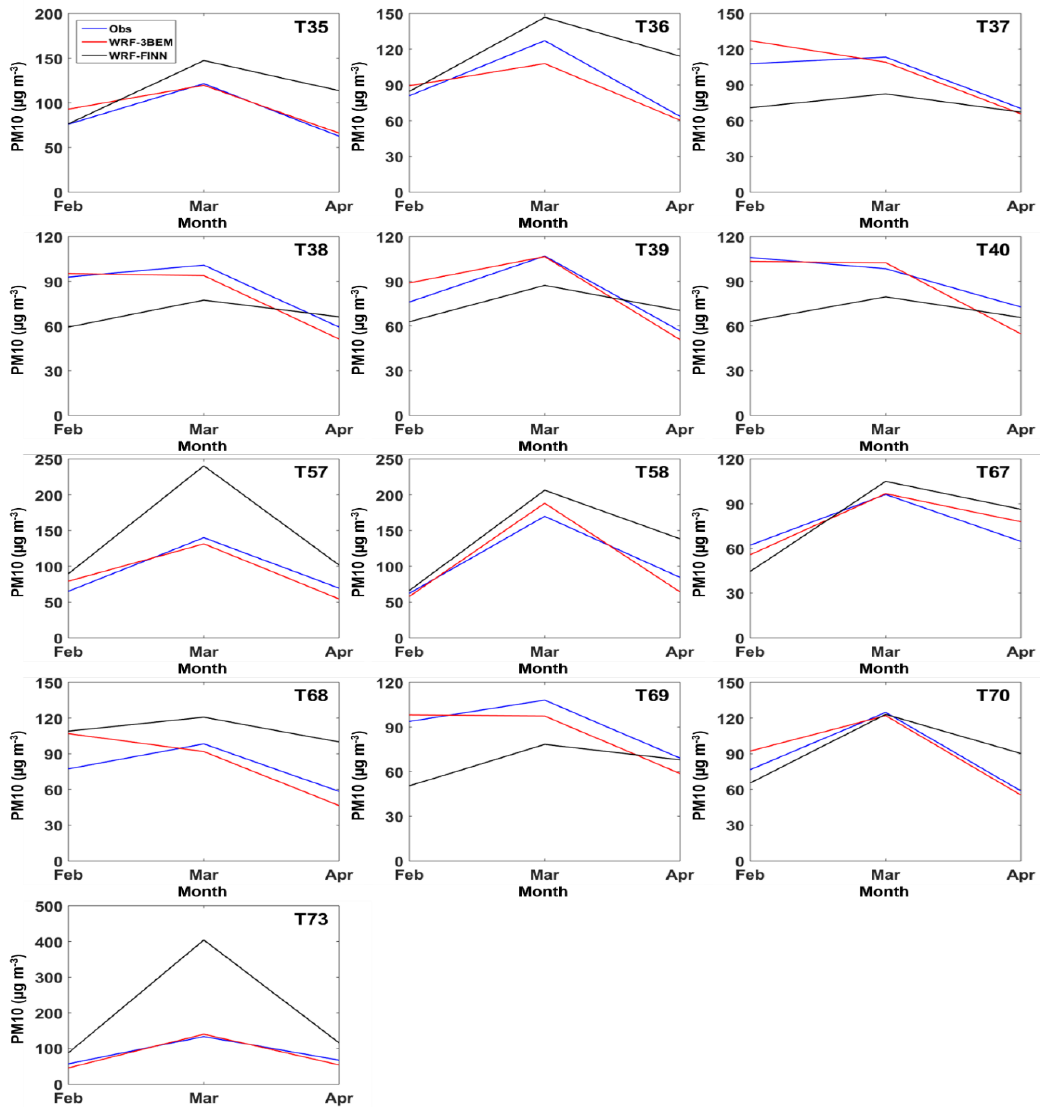
Figure 14. Comparisons of measured monthly average PM10 concentrations ( µ g m − 3 ) and simulations of WRF-3BEM and WRF-FINN for February–April 2015 for 13 ground stations.